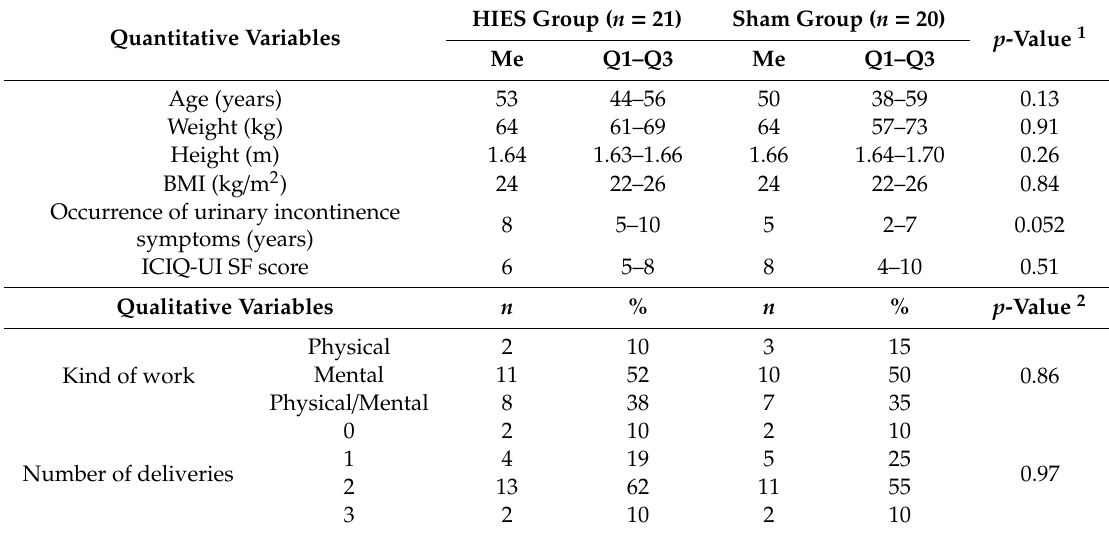
Figure 2. The CONSORT 2010 flow chart of patients in the study. Table 1. Urinary incontinence patients’ demographic and clinical characteristics in the HIES group and sham group.